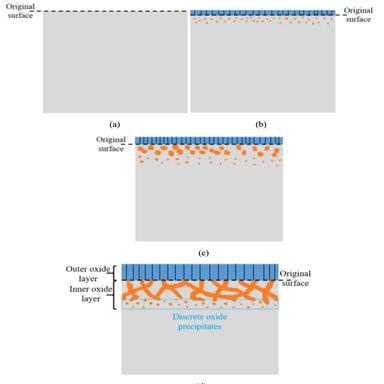
Schematic illustration of the process of high-temperature oxidation of Fe-17Cr-9Ni SS in steam at 600°C (ad).